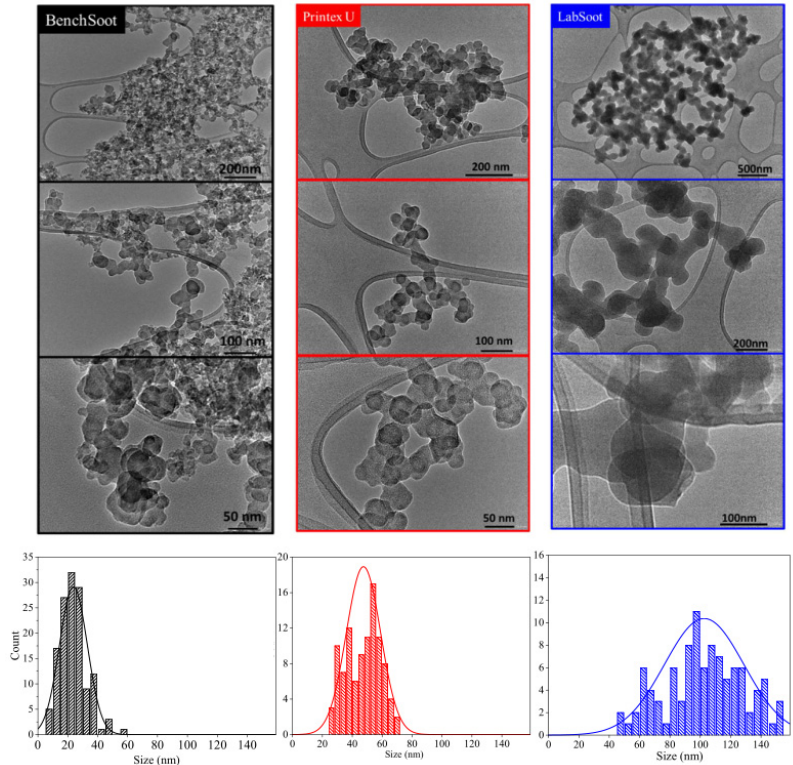
Figure 4. Soot nanostructure images using a high-resolution TEM and particle size distribution (bot- tom graphs).